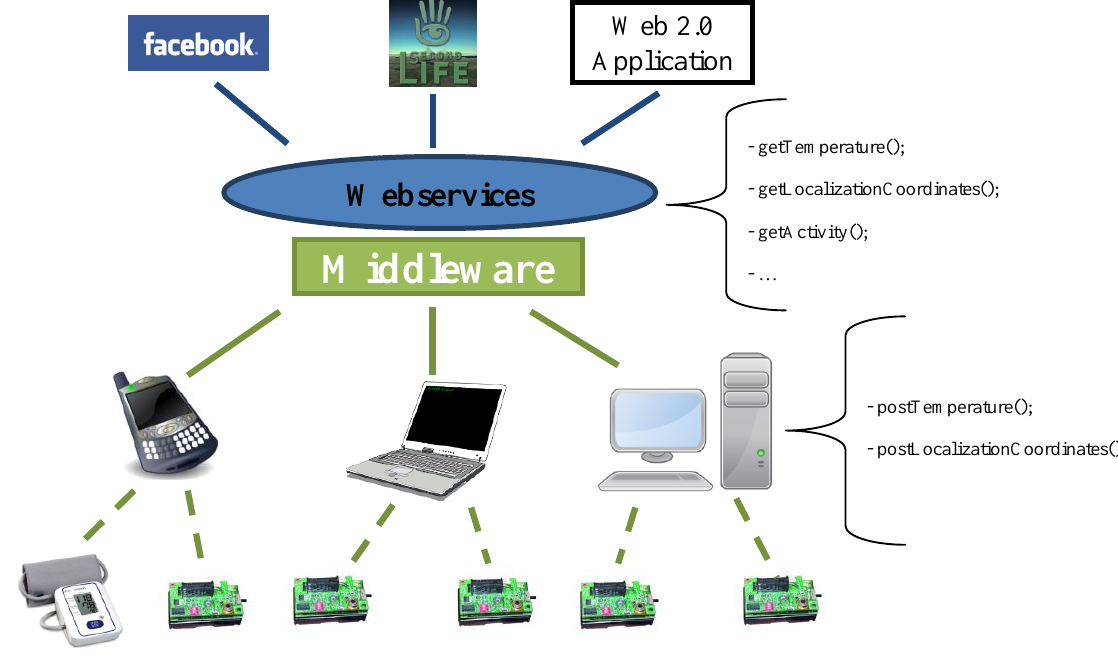
Figure 2. SocialSense’s current architecture and some examples of used